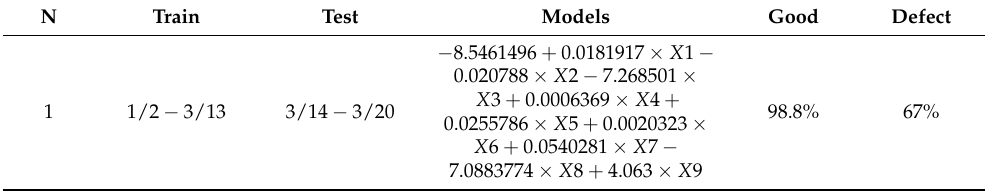
Table 4. The results of the cross-validation.